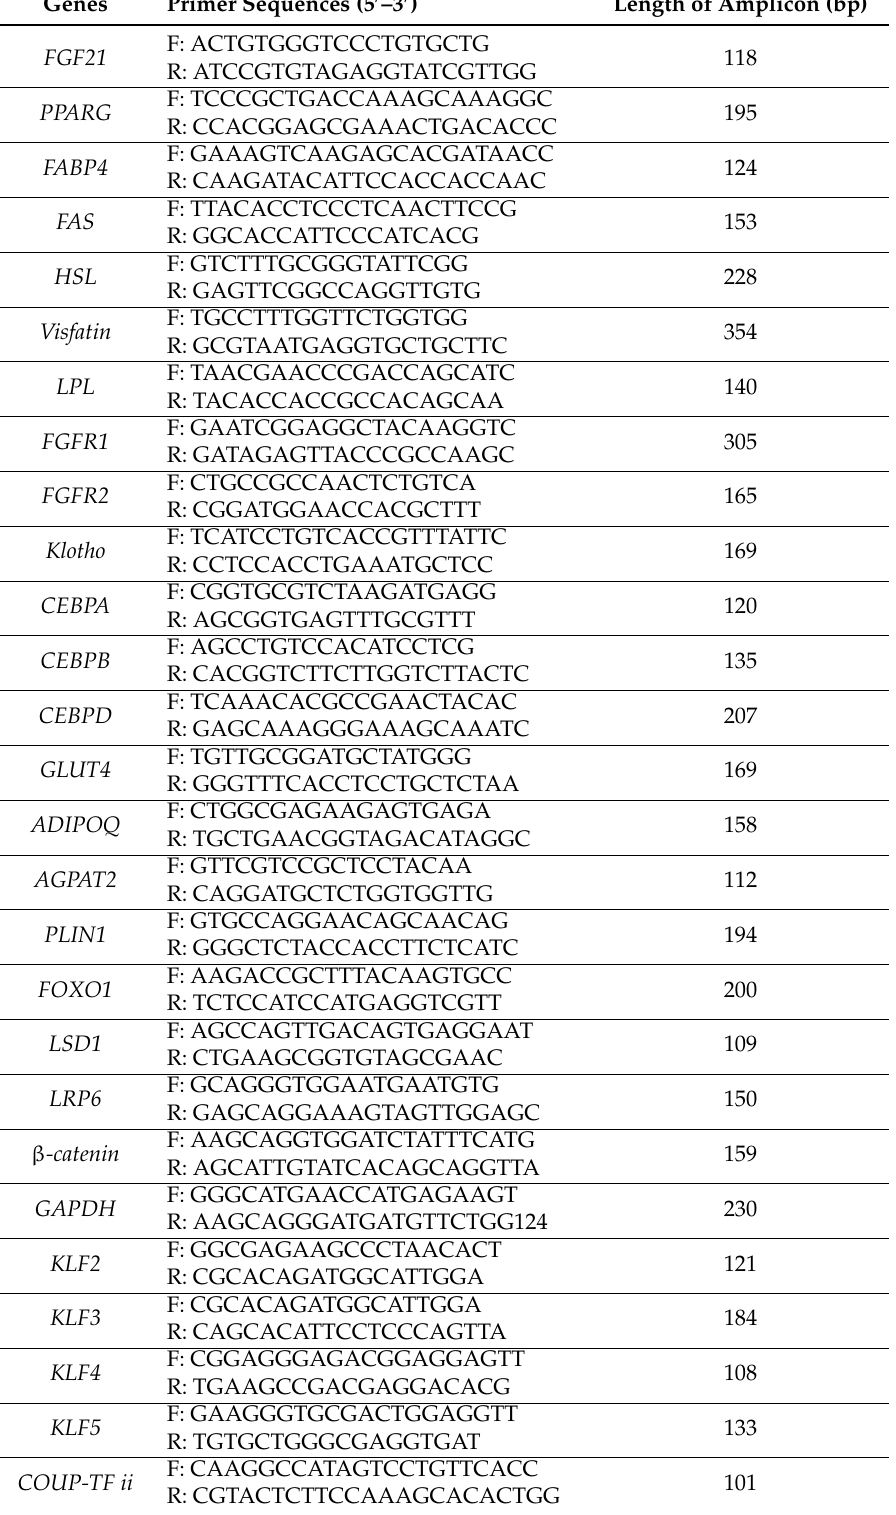
Table 1. Primer Sequences for